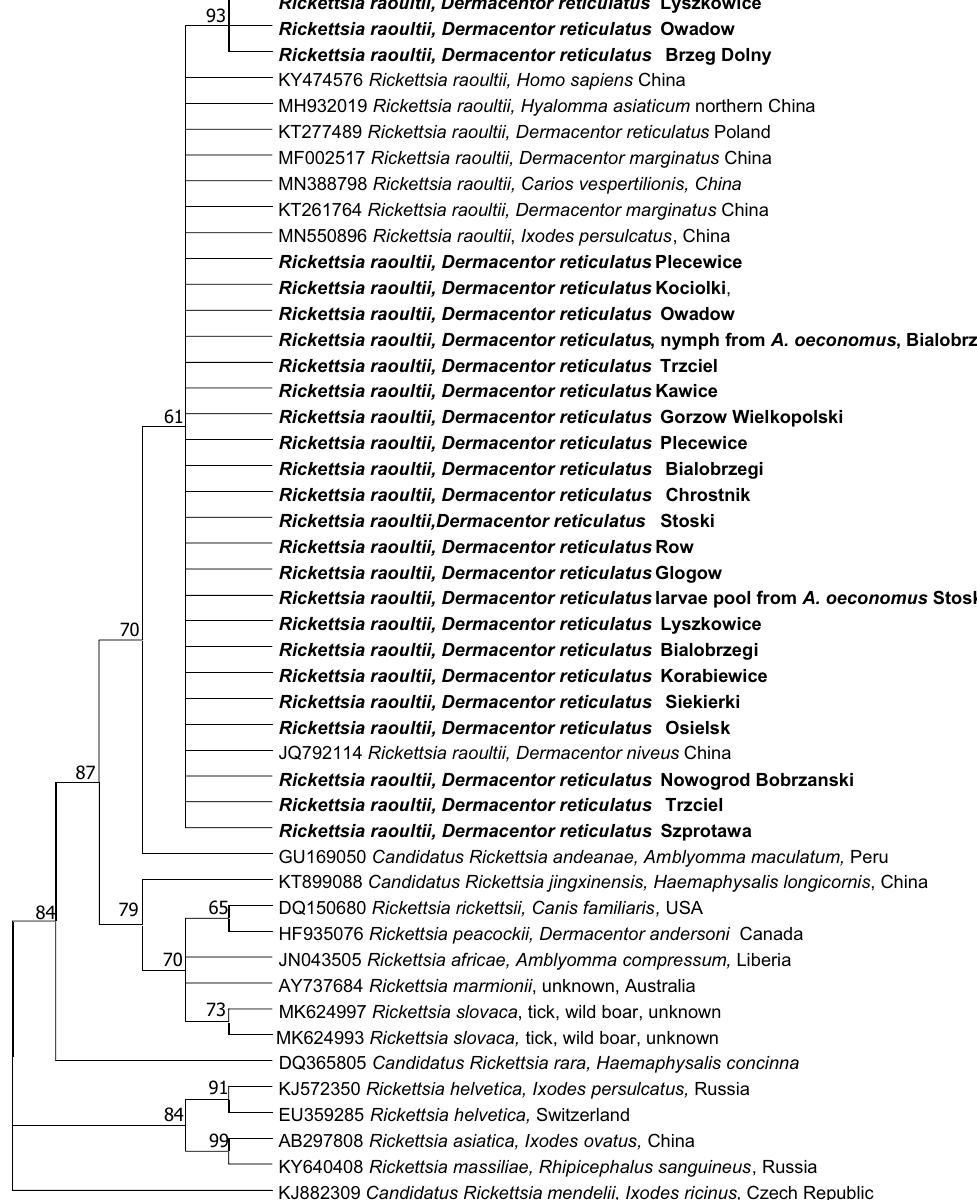
Figure 2. Molecular phylogenetic analysis of a 750 bp fragment of the citrate synthase ( gltA ) gene of Rickettsia raoultii . The evolutionary history was inferred by using the Maximum Likelihood method and Hasegawa- Kishino-Yano model. The tree with the highest log likelihood (− 1924.77) is shown. The percentage of trees in which the associated taxa clustered together is shown next to the branches. Initial tree(s) for the heuristic search were obtained automatically by applying Neighbor-Join and BioNJ algorithms to a matrix of pairwise distances estimated using the Maximum Composite Likelihood (MCL) approach, and then selecting the topology with superior log likelihood value. A discrete Gamma distribution was used to model evolutionary rate differences among sites (5 categories (+G, parameter = 0.3308)). This analysis involved 58 nucleotide sequences. There were a total of 703 positions in the final